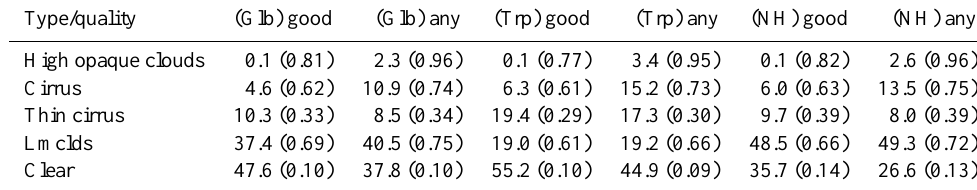
Table 1. AIRS cloud type frequencies and average emissivities (in brackets) for atmospheric profiles with good quality data (“good”) and for all data (“any”), separately over the globe (“Glb”), tropics (“Trp”) and Northern Hemisphere midlatitudes (“NH”). All seasons combined.